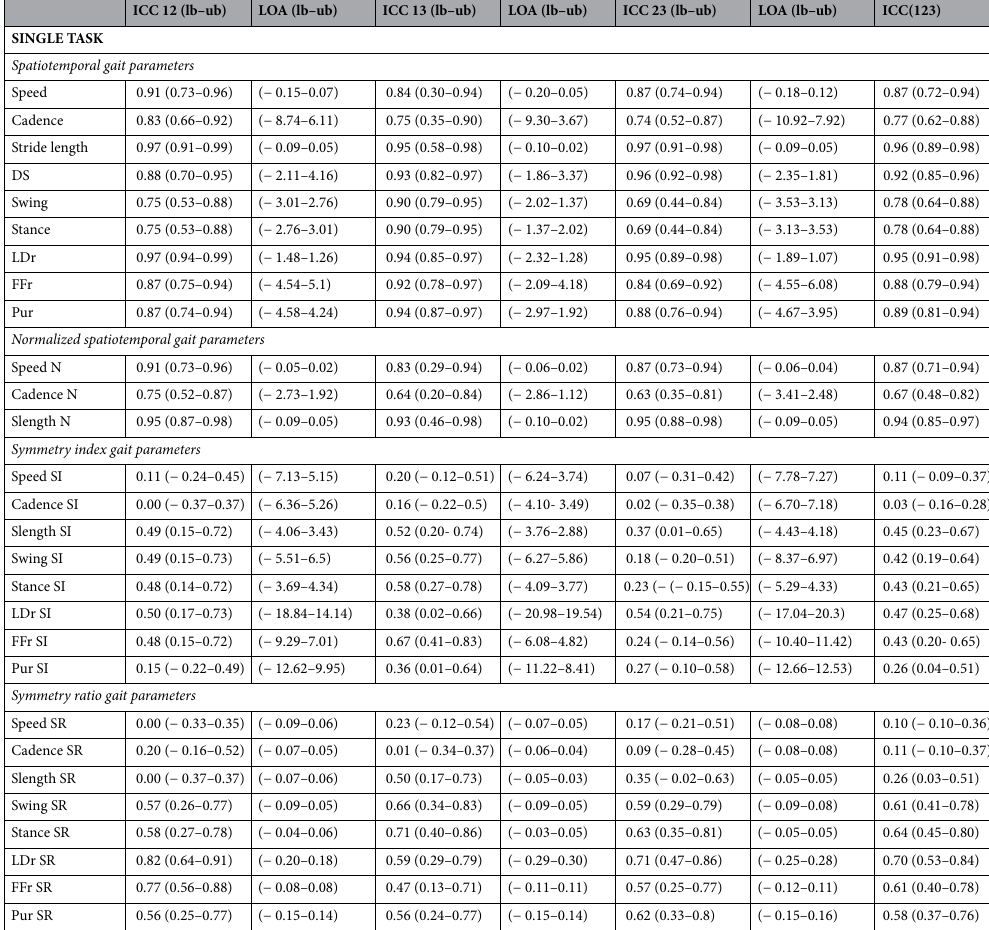
Table 2. Intraclass correlation coefficients (ICC) and limits of agreement (LOA) values for spatiotemporal gait parameters obtained in single task condition between the mean of the first and second trials (T1-T2), the first and the third trials (T1-T3), the second and the third trials (T2-T3) and the means of the three consecutive trials (T1-T2-T3). Abbreviations: ICC = intraclass correlation coefficient, LOA = limits of agreement, SI = symmetry index, SR = symmetry ratio, lb = lower bound, ub = upper bound, DS = double support, LDr = Load Ratio, FFr = Foot flat ratio, Pur = Push ratio, N =